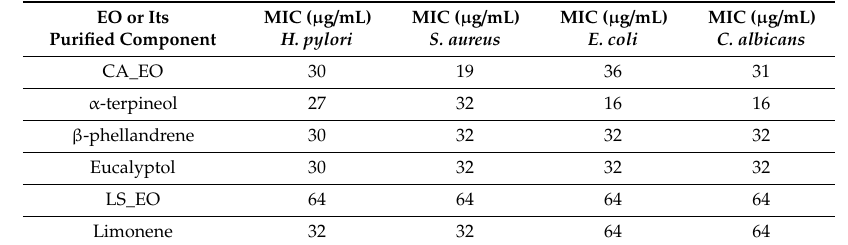
Table 3. The MIC values of CA_EO, LS_EO and their major components against clinical isolates